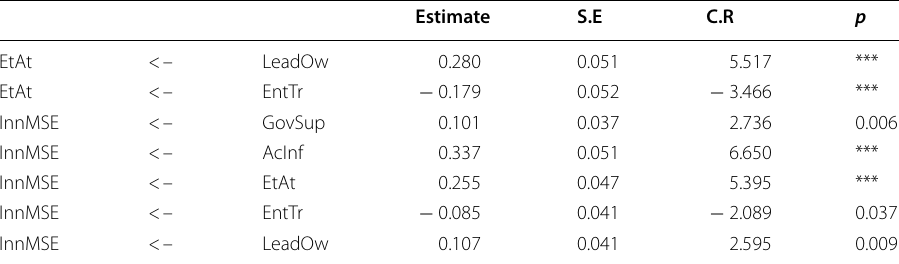
Table 7 Regression weights of the study